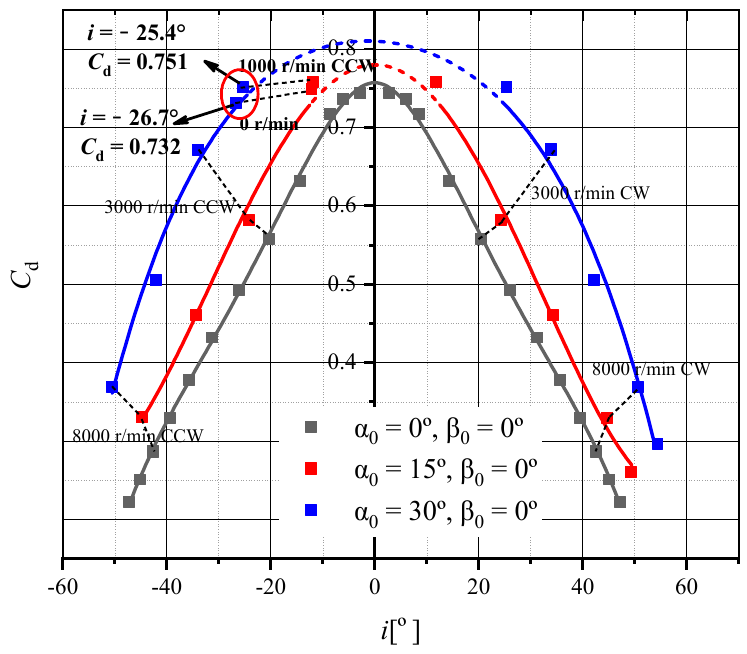
◦ , 15 ◦ , and 30 ◦ ). Figure 24. Relationship between 𝐶 and i under different radial inclination angles (0°, 15°, and 30°). Figure 24. Relationship between C d d and i under different radial inclination angles (0 The change in discharge coefficient with rotational speed for the same radial inclina- tion angle is further analyzed by presenting graphs of streamlines and velocity contours for different cross-sections, as shown in Figure 25. The combined effect of radial